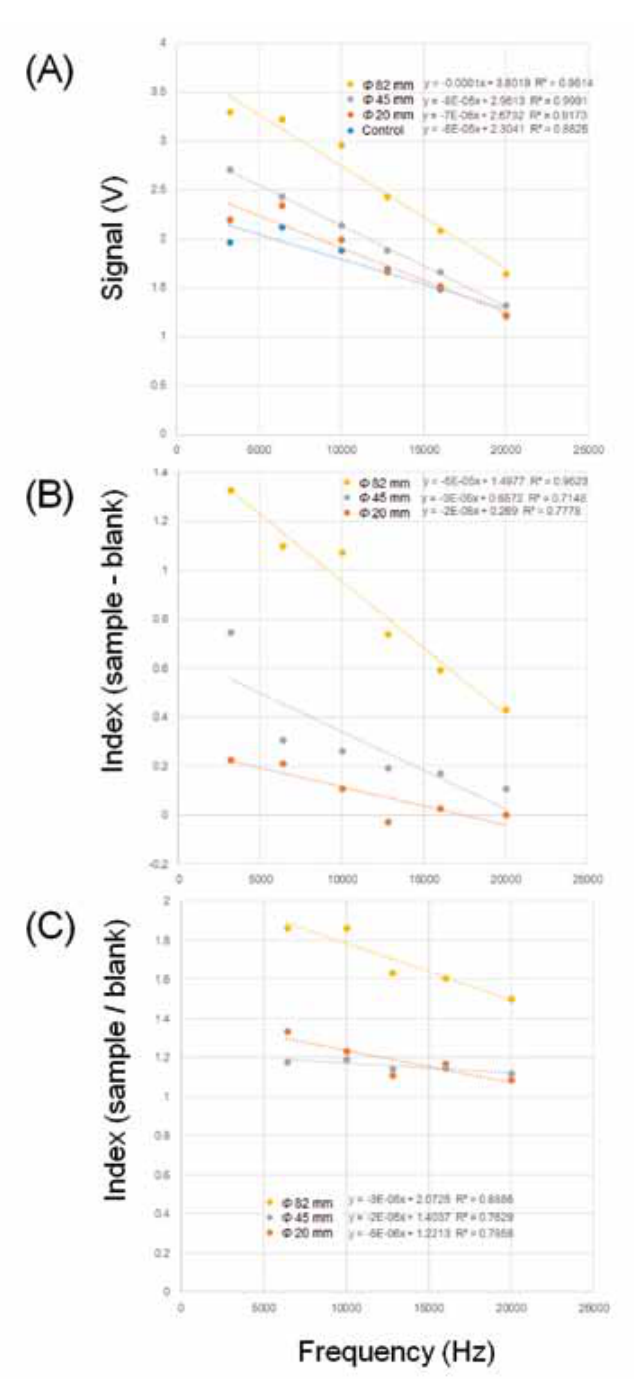
Fig. 3 - Signals for belowground tuberous roots differed in size based on the acoustic recording at the higher range of frequency (be- tween 3,200 and 20,000 Hz). Data recorded in the absence (blank control) and presence of tuberous roots of sweet potato (20, 45 and 85 mm in diameter) were plotted. Mean values ob- tained at each frequency were used (n = 5). (A) Plots and linear regression of raw signal. (B) Evaluation of the signal with the subtraction index (sample-blank). (C) Evaluation of the signal with the ratio index